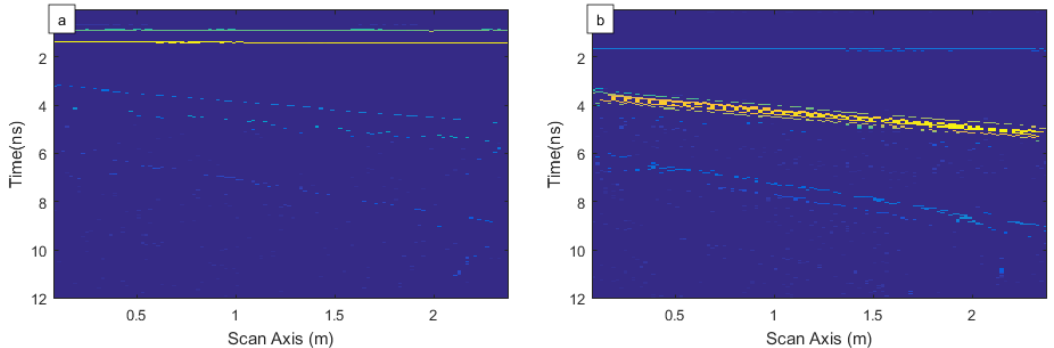
Figure 13. Frequency division section based on EEMD: ( a ) frequency division section at 1.0 GHz; and, ( b ) time-frequency spectrum at 1.2 GHz.